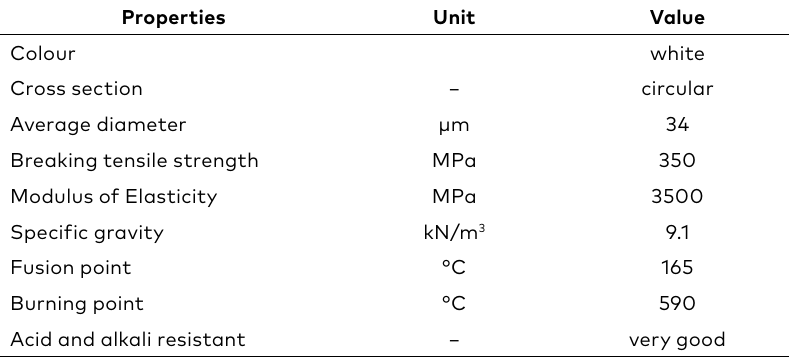
Table 3. Properties of polypropylene